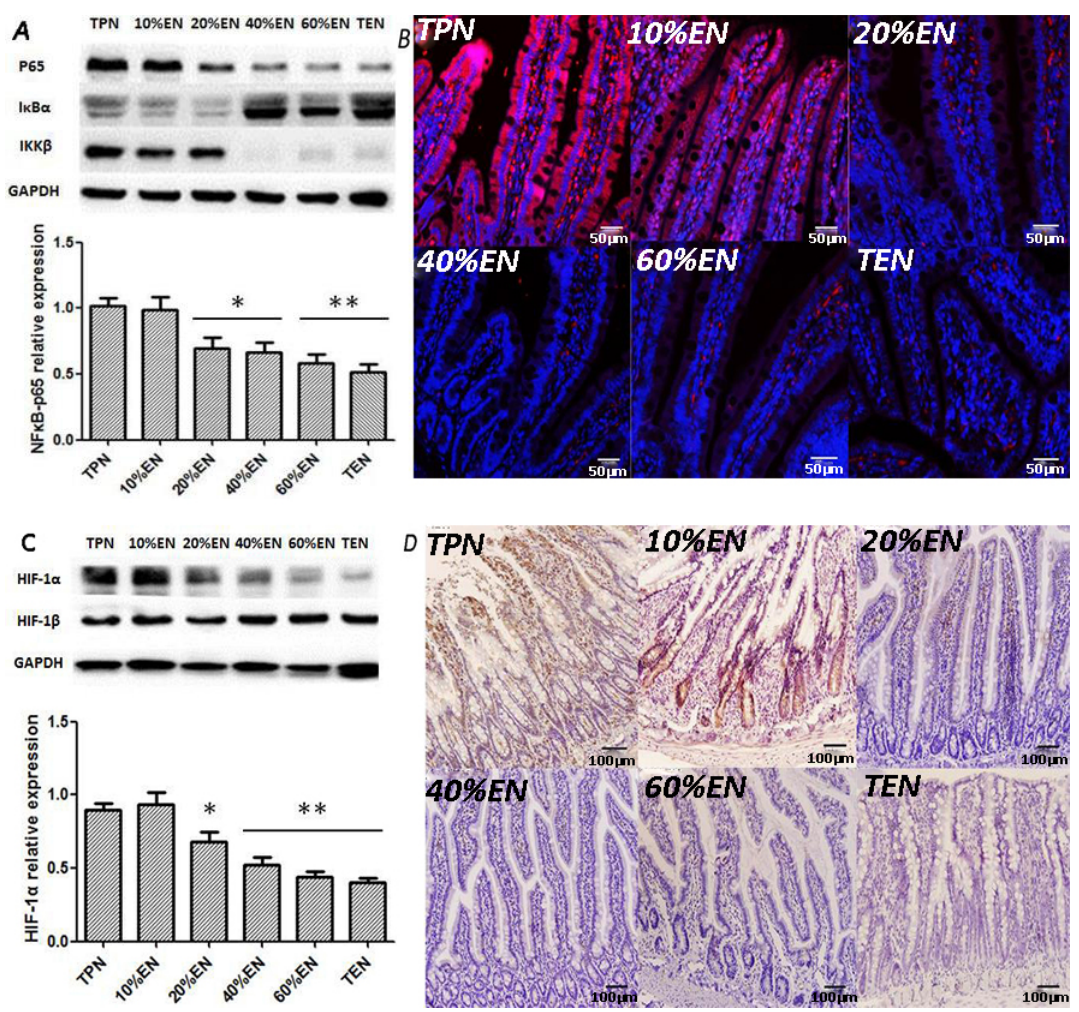
Figure 1. The comparison of NF- κ B/HIF-1 expressions in the intestine mucosa between groups. ( A ) Western blotting analysis of p65 protein; ( B ) Immunofluorescence analysis of p65 (red) and DAPI (blue). Compared with TPN group, 20% and 40%EN had a significantly lower expression of p65 protein ( p = 0.033 and 0.030, respectively). This downregulation was more apparently observed as the EN up to 60% and 100% ( p = 0.008 and 0.006, respectively); ( C ) Western blotting analysis of HIF-1 α and β subunit; ( D ) Immunohistochemical detection of HIF-1 α . Likewise, no difference of HIF-1 α expression was found between TPN and 10%EN groups. However, 20%EN group had a visibly decreased HIF-1 α abundance compared with TPN group ( p = 0.041). Also, in 40%, 60% and 100%EN groups, an even more significant decrease was found compared with TPN group ( p = 0.009, 0.007 and 0.007, respectively). No statistical difference of HIF-1 β was found between all the groups. * p < 0.05, compared with TPN group; ** p < 0.01, compared with TPN group.